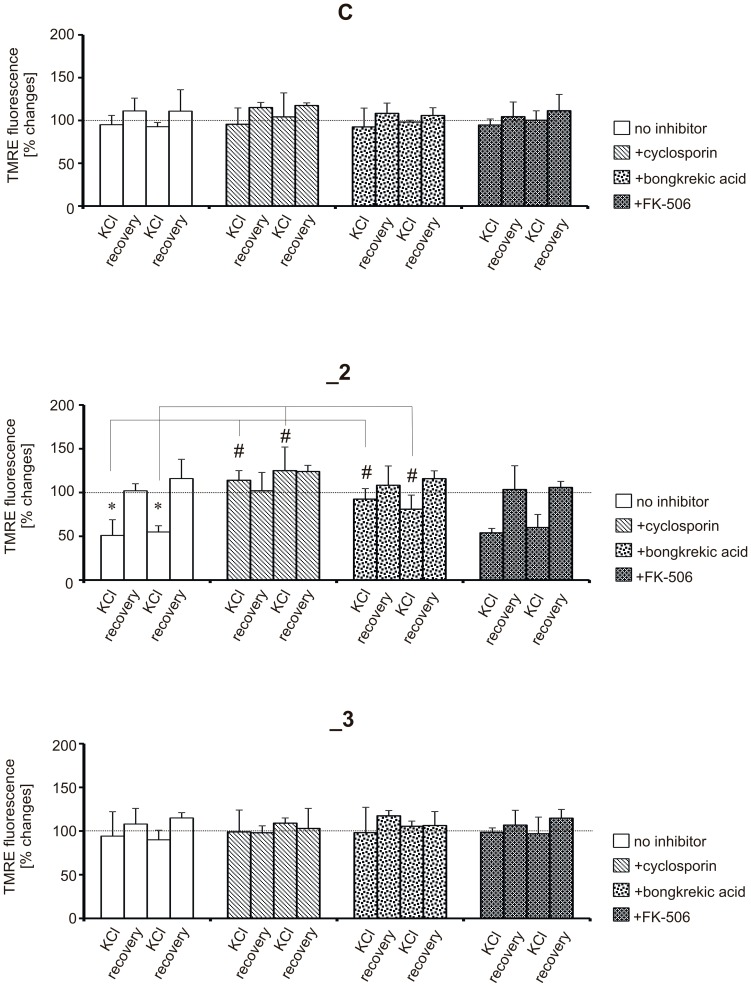
The effect of 59ΔΨm depolarizations.ΔΨm changes were measured 10 min after first KCl stimulation, 10 min after first KCl removal (first recovery phase), 10 min after second KCl stimulation and 10 min after second KCl removal (second recovery phase). The level of TMRE fluorescence in resting conditions (5 mM KCl) in each line was taken as 100% (dotted line). Cyclosporin (1 µM), bongkrekic acid (10 µM) or FK-506 (10 µM) were added 1 h before first KCl stimulation. * P<0.05, KCl stimulated vs. resting cells; # P<0.05, inhibitor treated cells vs. non-treated.